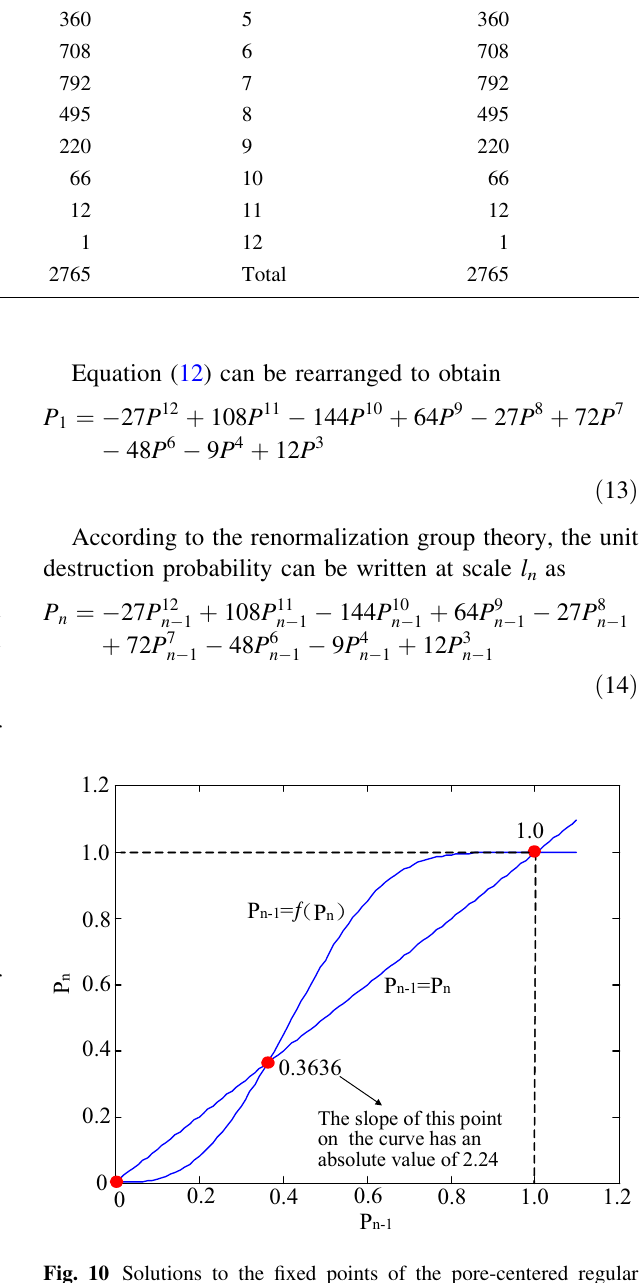
Fig. 10 Solutions to the fixed points of the pore-centered regular